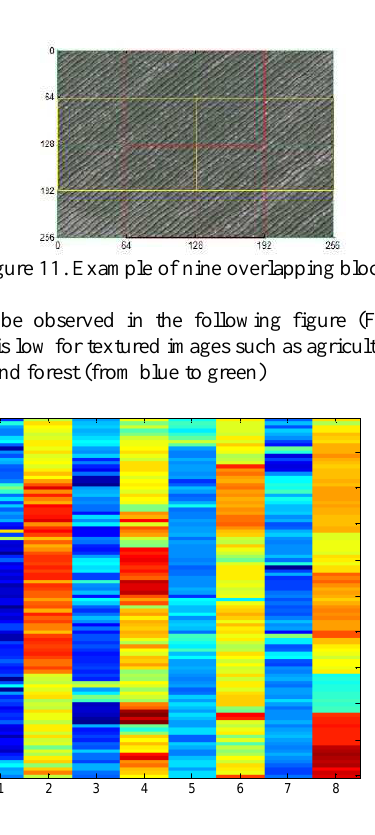
Figure 12. MRLV for each sample (1: agricultural, 2: airplane, 3: beach, 4: buildings, 5: chaparral, 6: dense residential, 7: forest, 8: harbor).